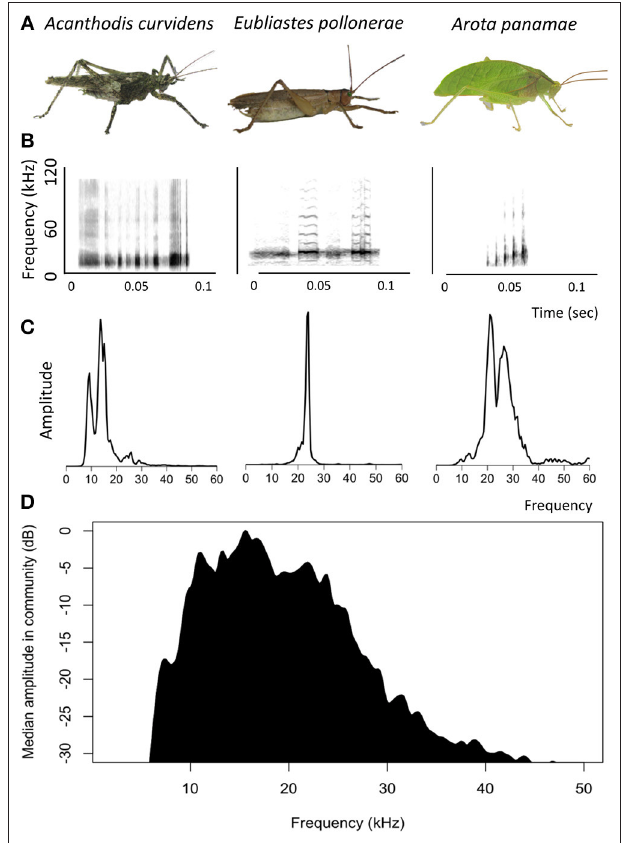
FIGURE 2 | Acoustic signals of katydids recorded on Barro Colorado Island, Panama. (A) Photographs of three katydid species. (B) Spectrograms of the calls of three katydid species. (C) Power spectra of the calls of three katydid species. (D) Median power spectrum of 34 katydid species common on Barro Colorado Island, Panama (three individuals per